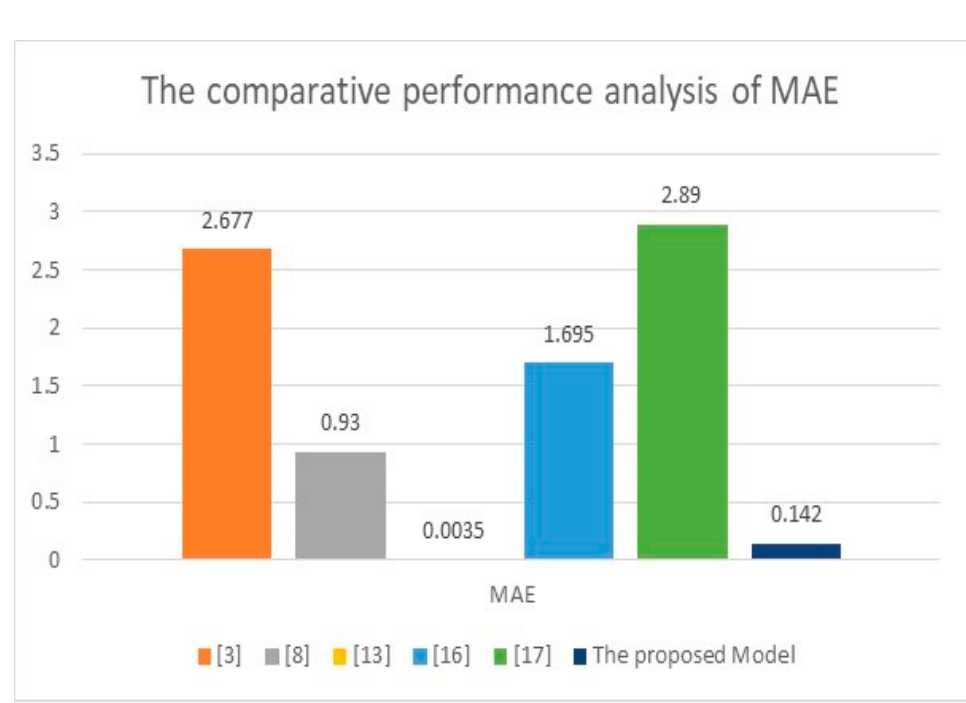
Figure 11. The comparative evaluation of the achieved MAE with different implemented methods [3,8,13,16,17].